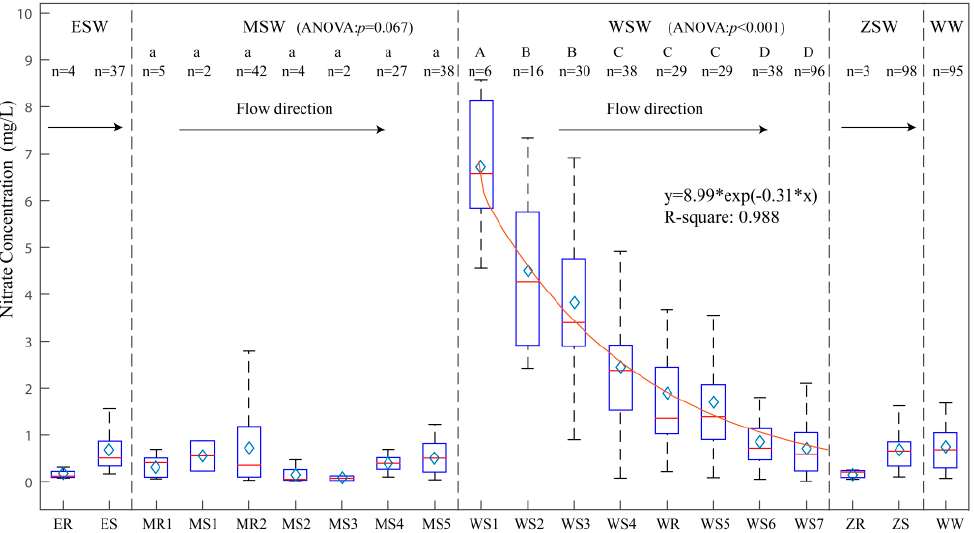
Figure 4. NO 3 − ‐ N concentration of surface water in different sampling sites and results of one ‐ way ANOVA. Figure 4. NO 3 − -N concentration of surface water in different sampling sites and results of one-way ANOVA.